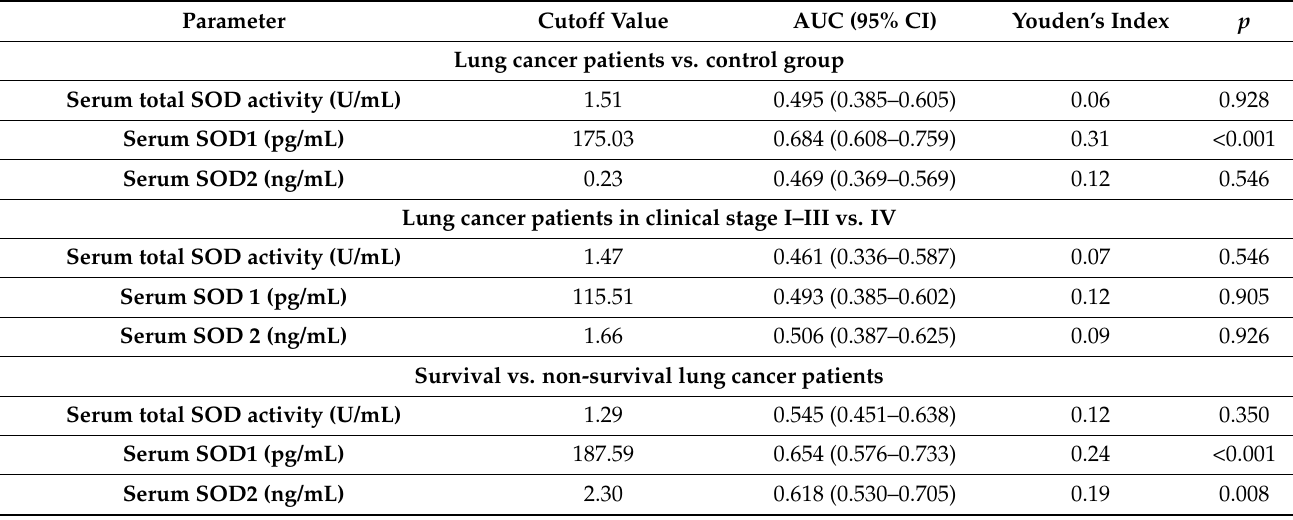
Table 2. Cutoff values, areas under the ROC curve (95% CI), and Youden’s indices for parameters differentiating lung cancer patients vs. the control group, lung cancer clinical stages I–III vs. IV, and survival vs. non-survival lung cancer patients. Parameter Cutoff Value AUC (95% CI) Youden’s Index p Lung cancer patients vs. control group Serum total SOD activity